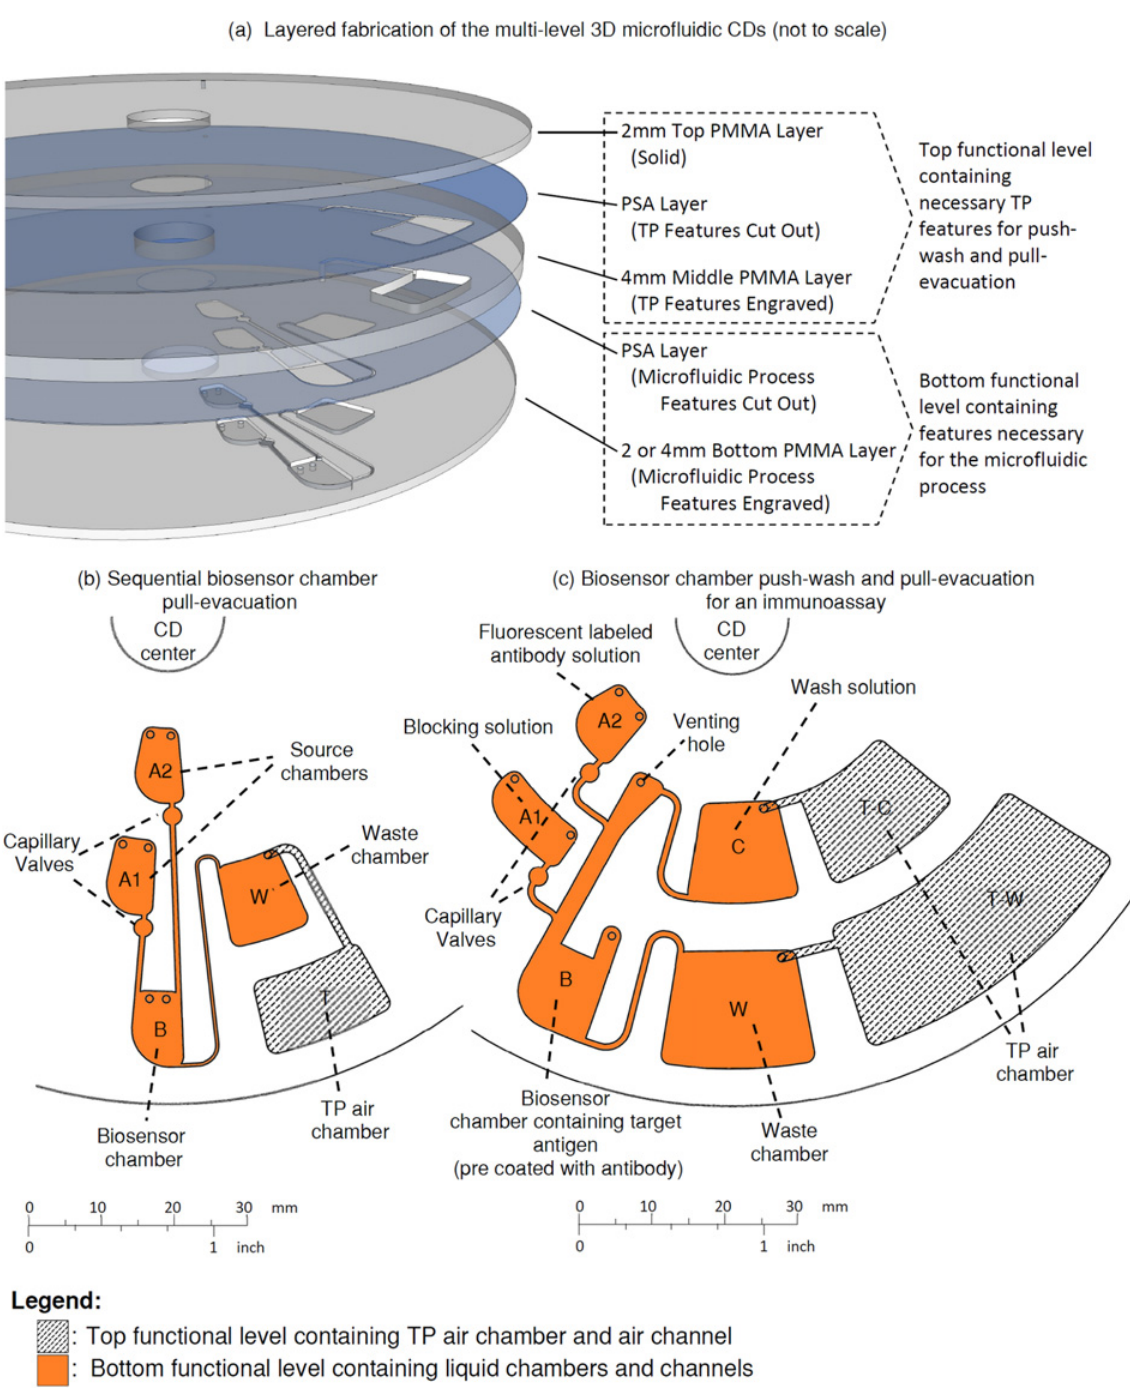
Fig 2. Microfluidic CD layers and demonstration CD designs. (a) Layered fabrication of multi-level 3D microfluidic CDs. (b) A design to demonstrate sequential biosensor chamber pull-evacuation. Liquid bursts from source chamber A1 into biosensor chamber B, then pull-evacuated into waste chamber W, followed by liquid bursting from source chamber A2 into biosensor chamber B, then pull-evacuated into waste chamber W. (c) A design to demonstrate biosensor chamber push-wash and pull-evacuation for an immunoassay. Target antigen in biosensor chamber B is washed off into waste chamber W, followed by the bursting of the blocking solution from source chamber A1 into biosensor chamber B, then rinsed and washed off into waste chamber W, and finally the bursting of flourescent labelled antibody solution from source chamber A2 to biosensor chamber B, then rinsed and double volume washed into waste chamber